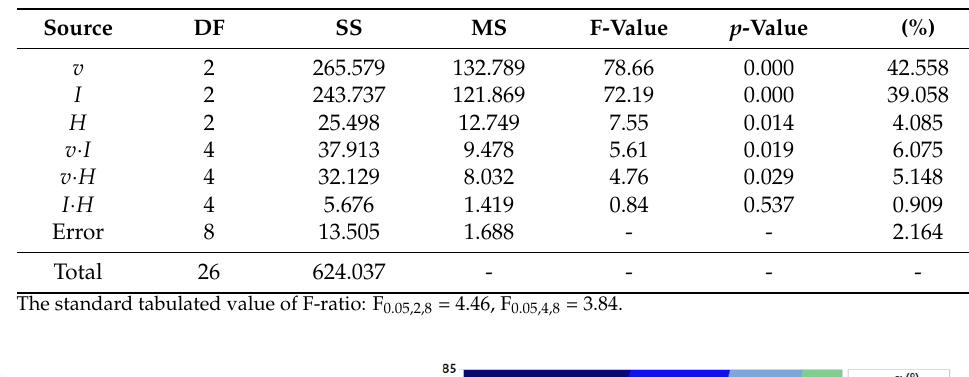
Figure 7. Experimental bevel angle vs. predicted bevel angle. Table 7. ANOVA for bevel angle.